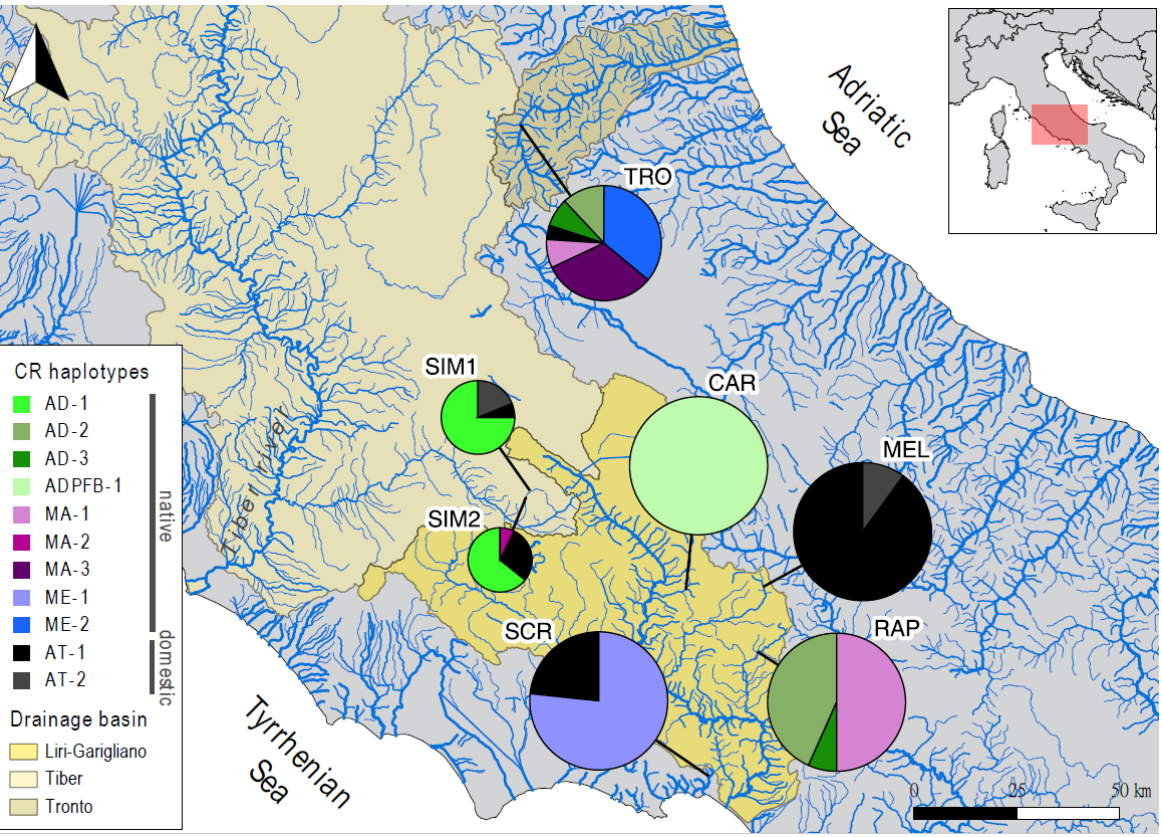
Figure 1. Frequency and geographic distribution of 11 Control Region (CR) haplotypes across seven wild sampling sites from three drainage basins in central Italy. Population abbreviations refer to Table 1; pie charts are proportional to sample sizes.